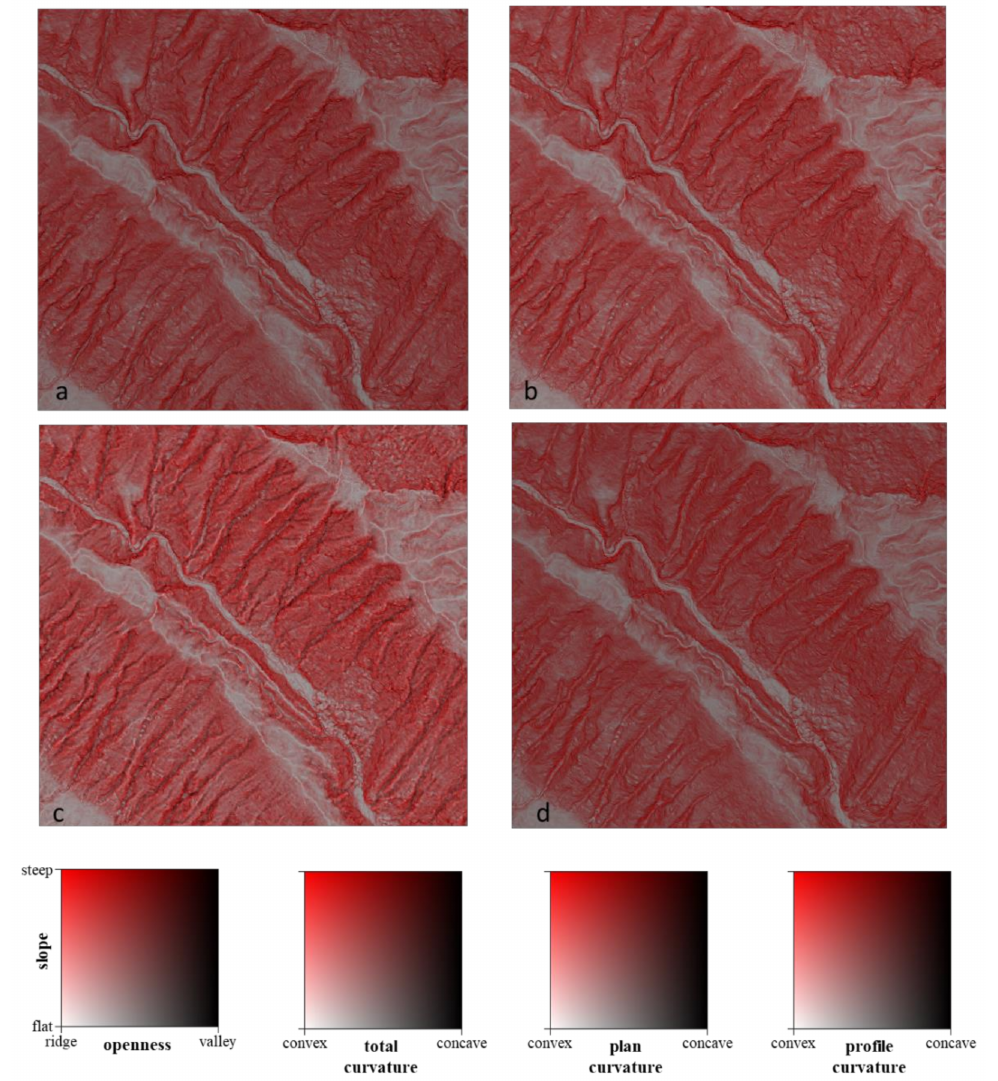
Figure 3. ( a ) 2P relief maps with slope and openness, ( b ) slope and total curvature, ( c ) slope and plan curvature, and ( d ) slope and profile